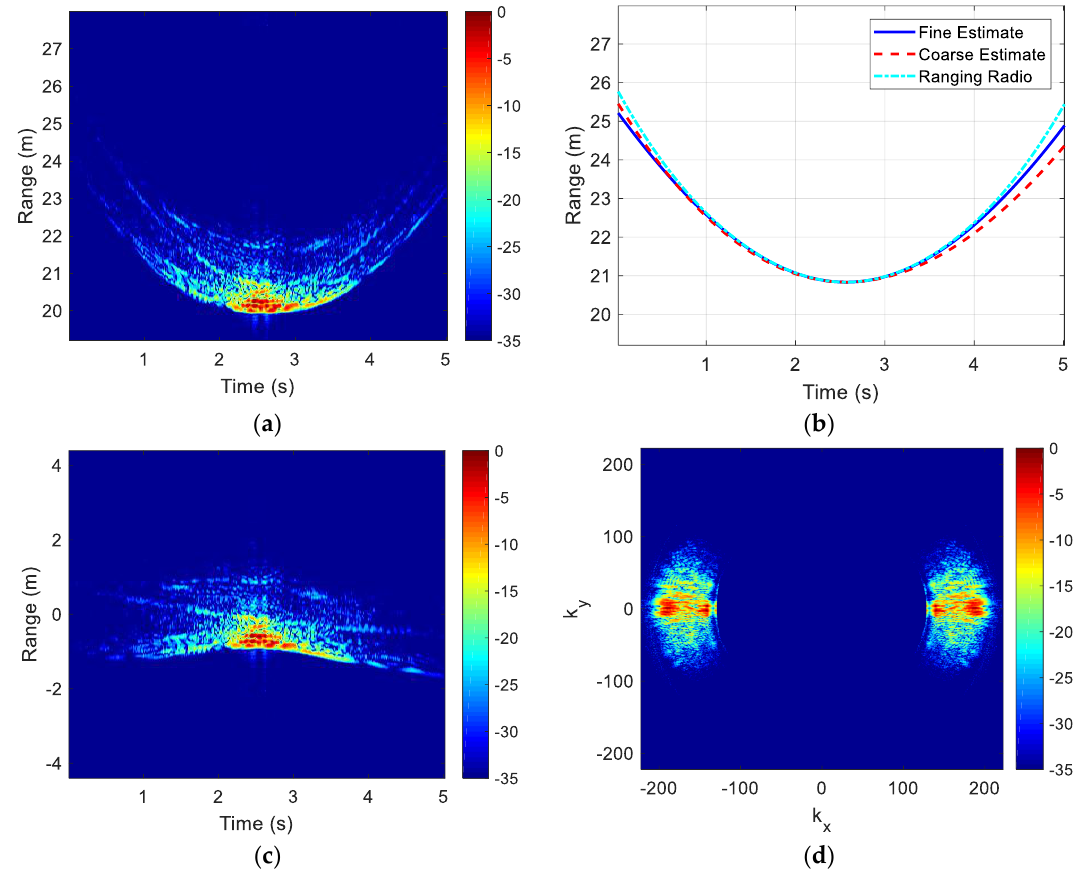
Figure 2. Vehicle measurement processing. ( a ) Raw range profiles; ( b ) Range alignment curves; ( c ) Aligned range profiles; ( d ) k -space data.